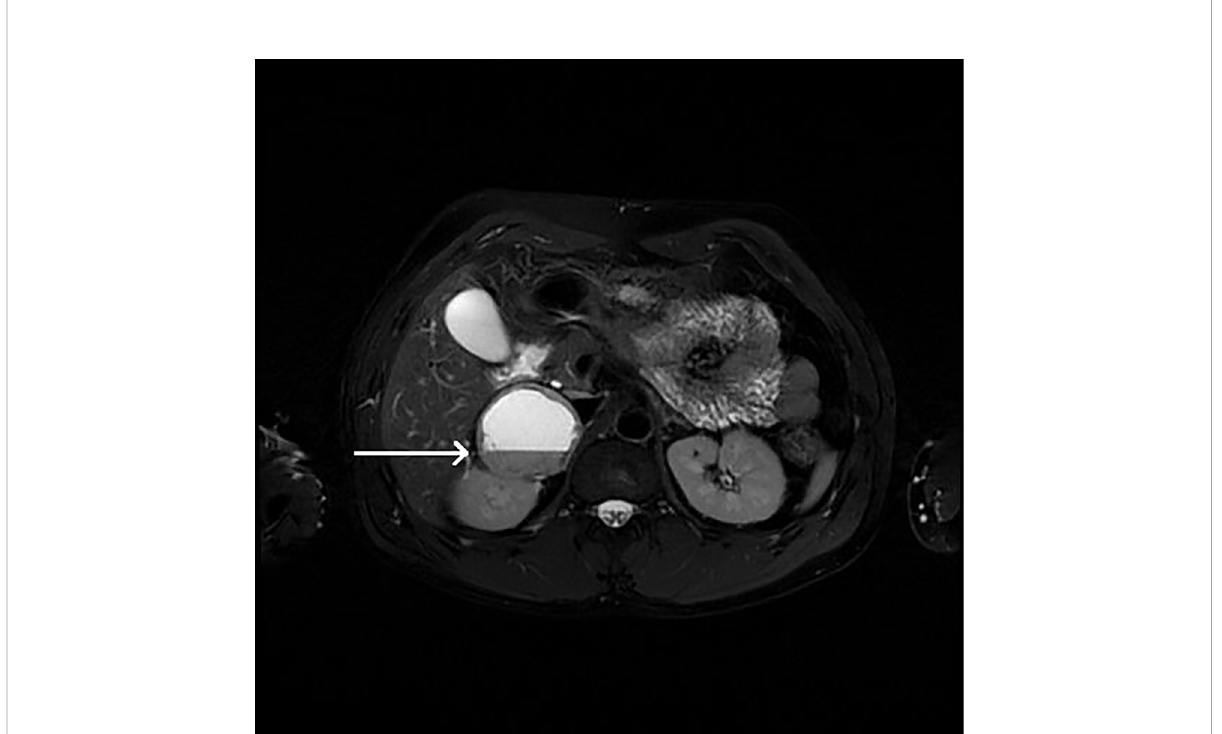
FIGURE 5 Patient number 5: MRI of the abdomen, T2-weighted axial image – right adrenal lesion with mostly hyperintense signal with fl uid- fl uid level (thin arrow).